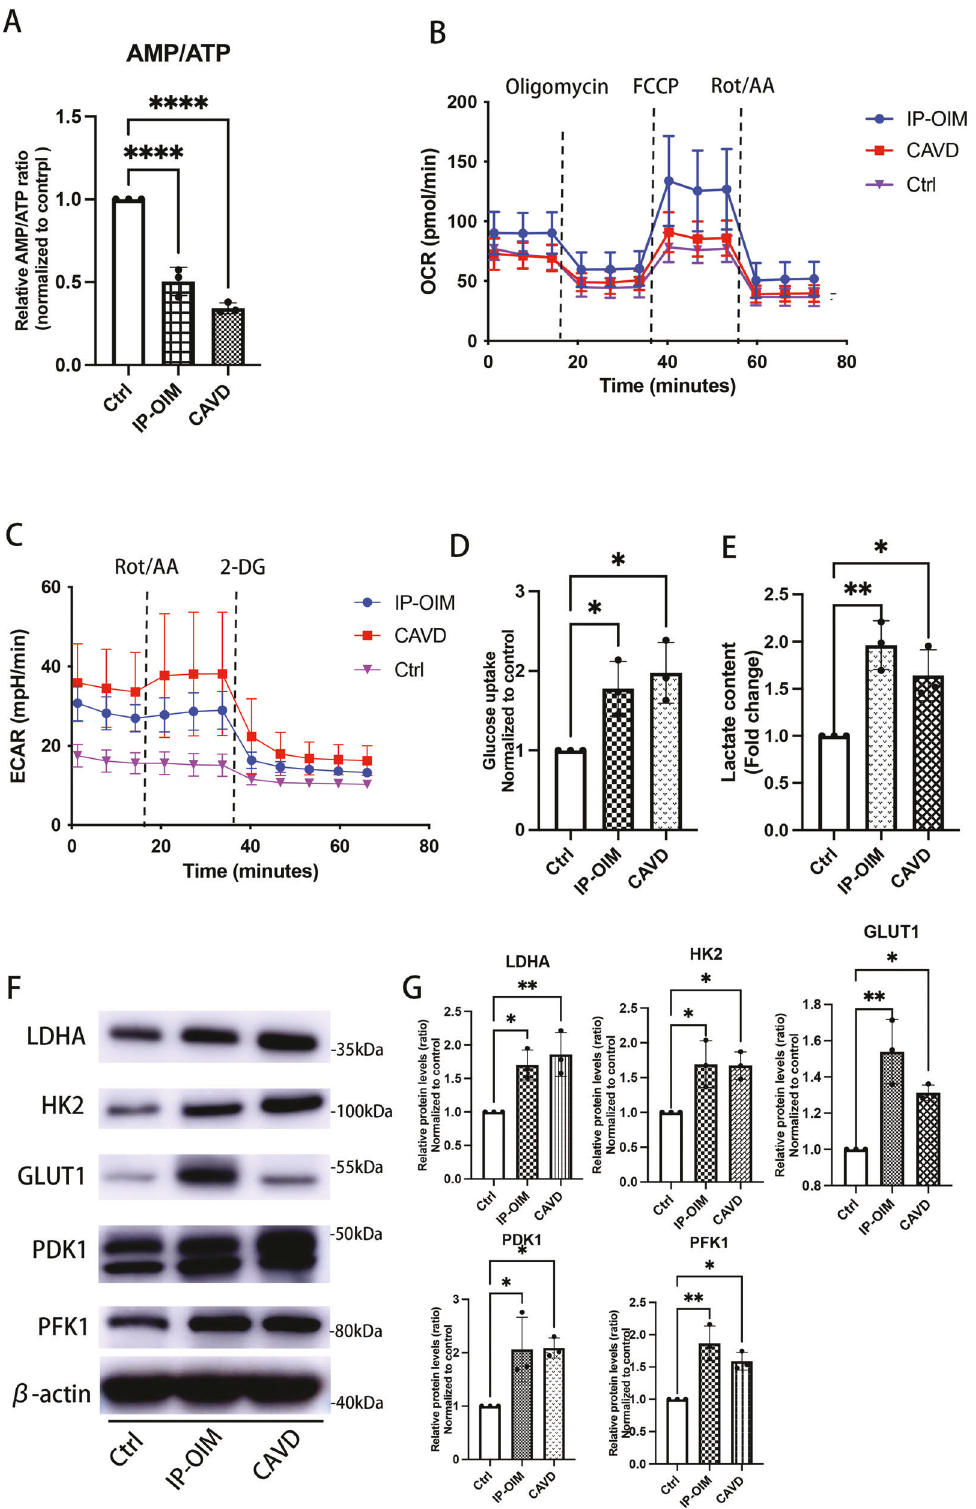
Fig. 5 Human VICs from IP-OIM and CAVs appeared Warburg effect. A AMP/ATP ratio in human VICs isolated from non-calci fi ed and calci fi ed aortic valves, and human VICs from IP-OIM (one-way ANOVA followed by Bonferroni post hoc test). B , C Seahorse pro fi les for oxygen consumption rate (OCR) and extracellular acidi fi cation rate (ECAR) for human VICs isolated from non-calci fi ed and calci fi ed aortic valves, and human VICs from IP-OIM. D , E Glucose consumption rate and lactate content in calci fi ed VICs from CAVs and IP-OIM, and normal VICs (one- way ANOVA followed by Bonferroni post hoc test). F Western blot and ( G ) quanti fi cation for LDHA, HK2, GLUT1, PDK1 and PFK1 in calci fi ed VICs from CAVs and IP-OIM, and VICs isolated from non-CAVs (one-way ANOVA followed by Bonferroni post hoc test). β -actin was used as loading control. Data are shown as mean ± SD. * P < 0.05, ** P < 0.01, *** P < 0.001, **** P < 0.0001.